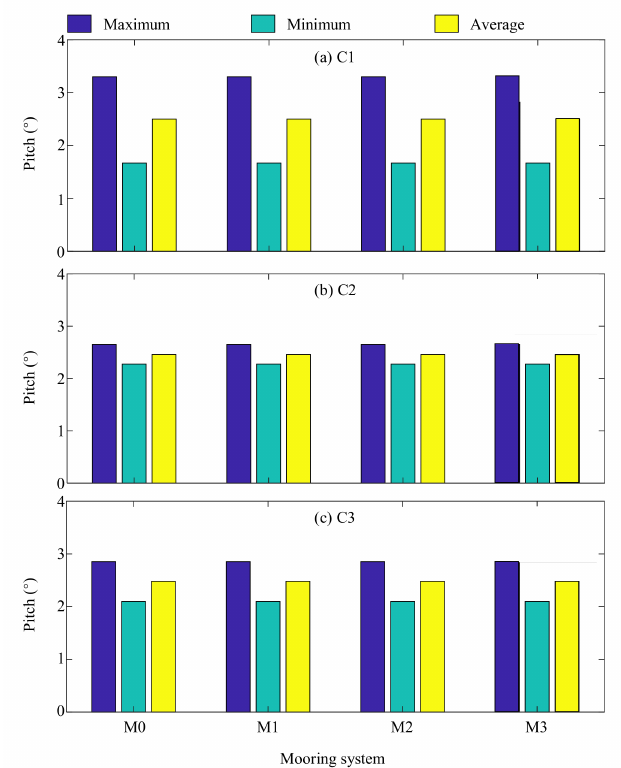
Figure 9. Maximum, minimum, and average values of wind turbine pitch movement time series with M0–3 when under: ( a ) C1; ( b ) C2; ( c )